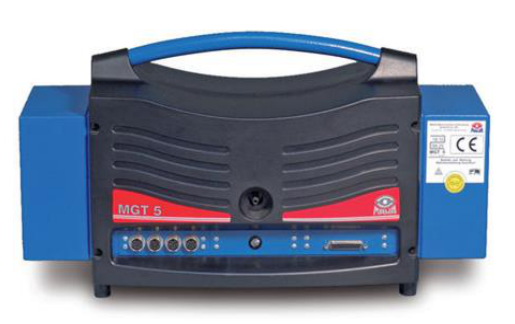
Fig.8. Test stand of the Fiat 1.1 engine